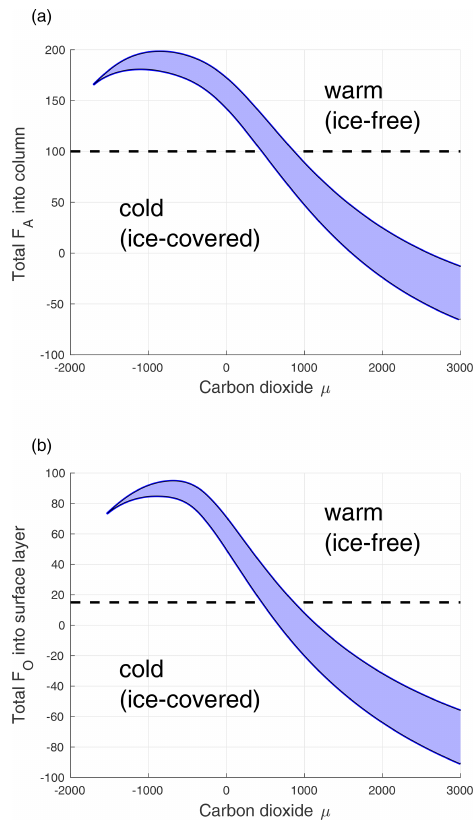
Figure 5. (a) Bifurcation diagram showing locations of saddle-node bifurcations as F tot and µ are varied. The dashed line indicates the A value of F tot used in the model. The shaded area between the curves A is the region of bistability. Abrupt transition from a cold state to a warm state occurs on the right curve, while abrupt transition from a warm state to a cold state occurs on the left curve. (b) Same except F O is the varying parameter on the vertical axis rather than F tot